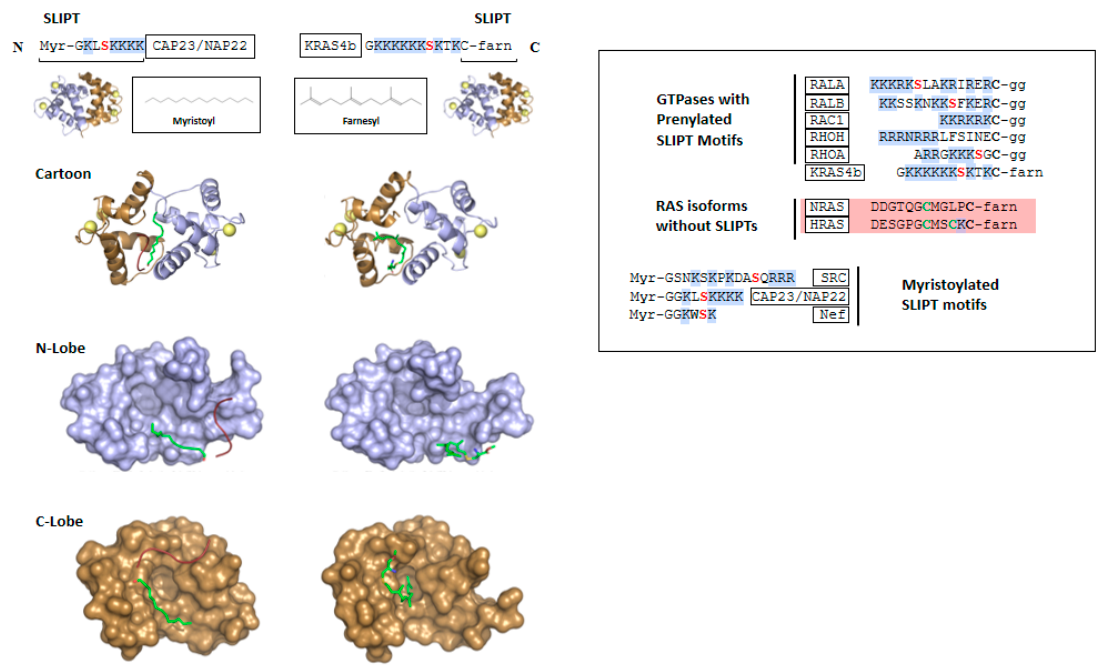
Figure 2. The Singly Lipidated Polybasic Terminus (SLIPT) non-canonical calmodulin-binding motif. Top: sequence of the myristoylated SLIPT motif in CAP23 / NAP22 and the farnesylated SLIPT in KRAS4b. Middle: Ribbon models of Ca 2 + -calmodulin in complex with a myristoylated N-terminal peptide of CAP23 / NAP22 (PDB accession code 1L7Z) and farnesyl cysteine methyl ester (FCME), representing the farnesylated C-terminal residue of KRAS4b (PDB 6OS4). The calmodulin C-terminal and N-terminal lobes are coloured brown and blue, respectively, with lipids in green and peptidyl moieties of the targets in red. Bottom: Space filling models of the N-terminal and C-terminal lobes of calmodulin showing how the SLIPT motifs interact. Right panel: Sequences of SLIPT motif sequences from KRAS4b, other small GTPase proteins and myristoylated proteins. Sequences of RAS isoforms lacking SLIPT motifs are also shown. Reported phosphorylation sites are red, palmitoylation sites are green and basic residues are highlighted in blue. Myr, Myristoyl; farn, farnesyl; gg,